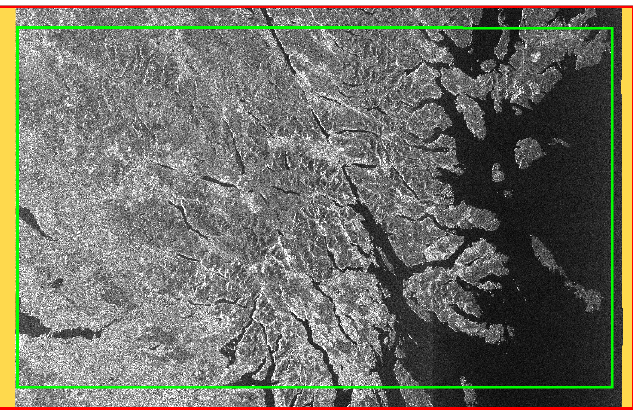
Figure 11. Sentinel-1 tile S1A_IW_GRDH_1SDV_20191012T063817_20191012T063842_029422_0358AF _5701 Amplitude VH footprint. The footprint provided by Copernicus is highlighted in red, no-data layer is highlighted in yellow, buffered footprint is highlighted in